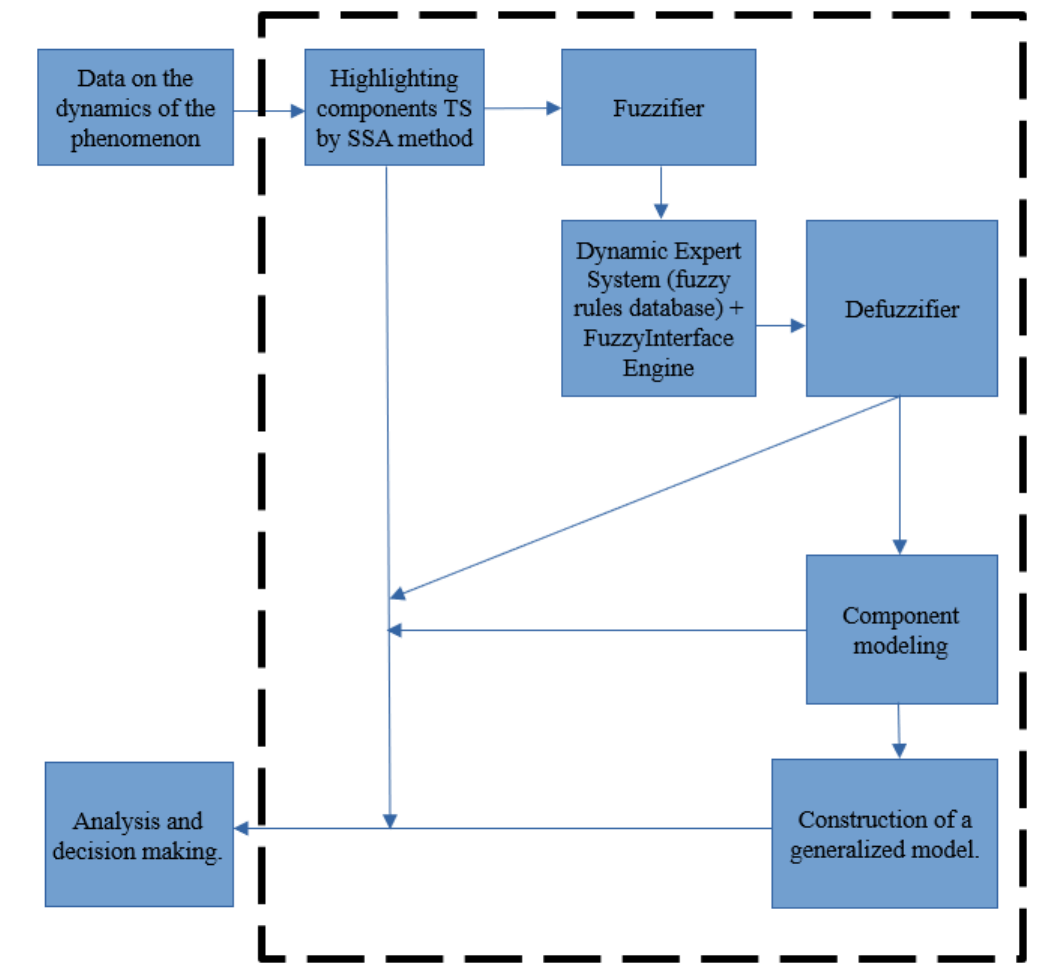
Figure 1. A generalized structural diagram of the dynamics analysis based on fuzzy processing of time series components obtained with SSA.